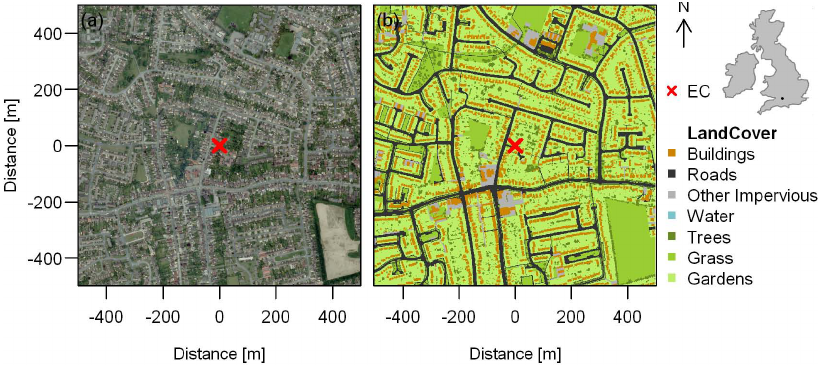
Fig. 1. (a) Aerial photograph (2009, © GeoPerspectives) and (b) land cover map for ± 500m around the flux mast (EC). The large area southeast of the mast classified as grass in (b) has since been built on (it can be seen undergoing development in (a) ). The location of Swindon within the British Isles is shown (top right).